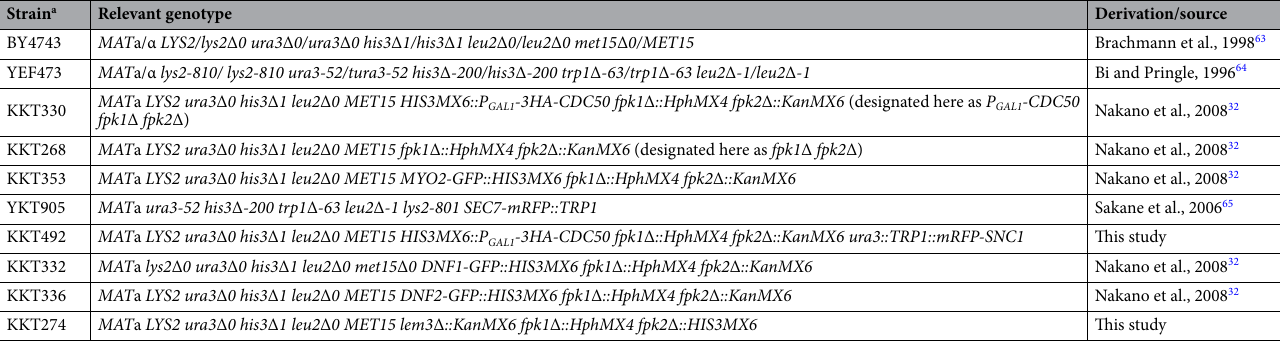
Table 1. Yeast strains used in this study. a KKT strains are isogenic derivatives of BY4743. YKT strains are isogenic derivatives of